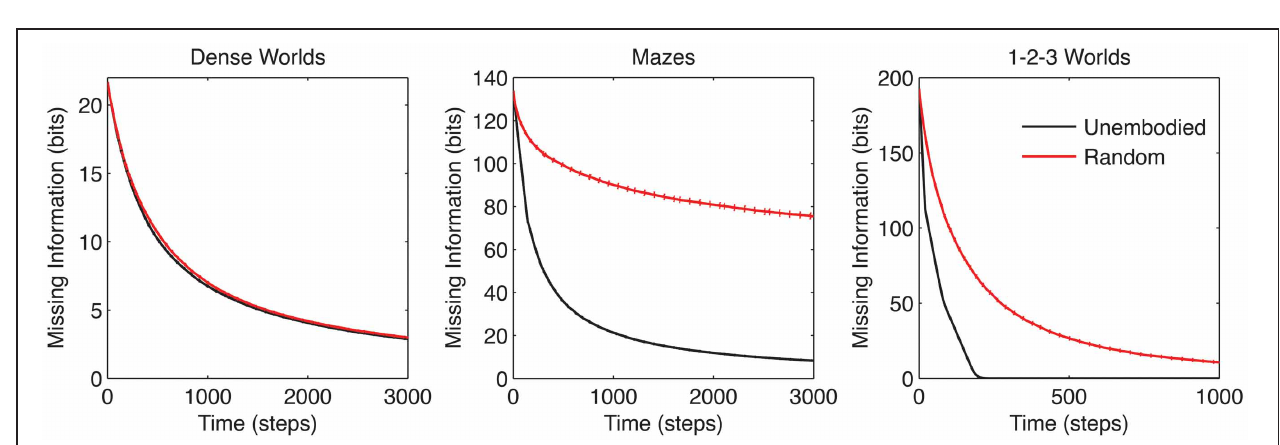
Frontiers in Neural